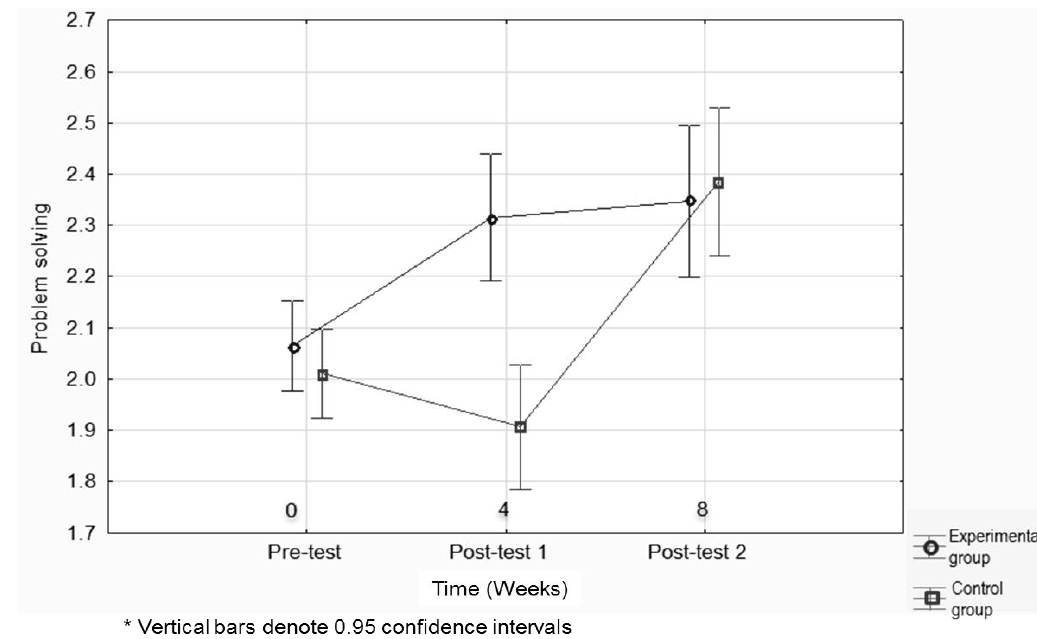
Figure 2 Problem-solving scores